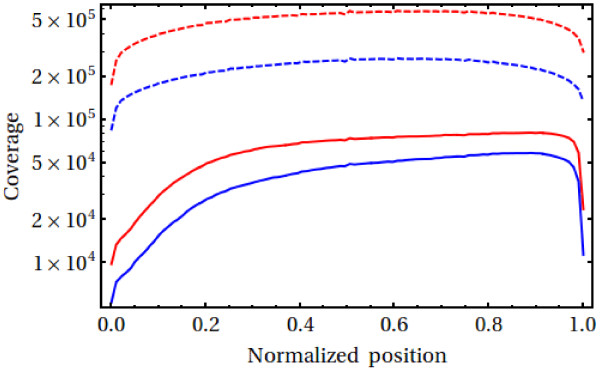
Coverage of full length wheat cDNAs and tentative contigs by our assembled sequences. The individual curves correspond to lower cut-offs for the %IDs required to define a match (from top to bottom, 90 and 99%, respectively; E-value <10-50 for all curves). Coverage of full length cDNAs [29] are shown as solid lines, coverage of the Harvard tentative contigs [32] as dashed lines. Nucleotide positions are relative to the total length of the full length cDNAs and tentative contigs, respectively.